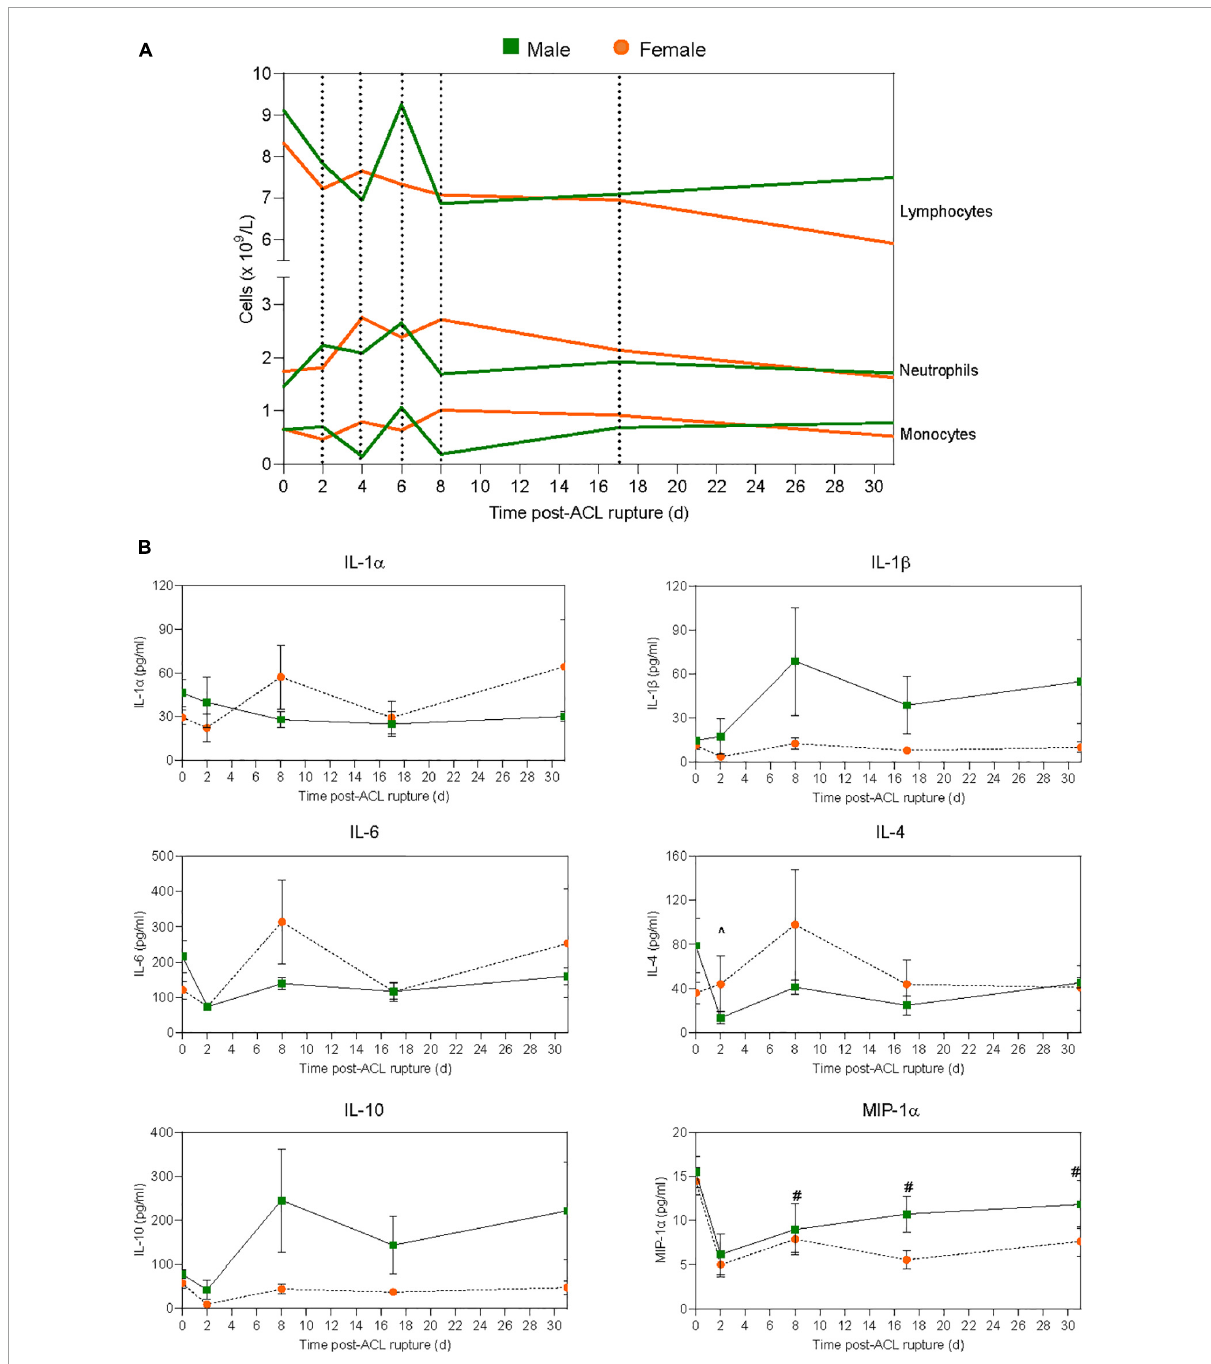
FIGURE2 Systemic inflammatory responses to ACL rupture. Changes in (A) circulating lymphocyte, neutrophil, and monocyte numbers, and (B) plasma cytokine levels for male (green) and female (orange) animals to day 31 following ACL rupture. IL, interleukin; MIP, macrophage inflammatory protein. Data show mean (hematology) and mean ± SEM (cytokines). Two-way ANOVA, Sidak’s multiple comparisons test, ∧ p < 0.05 male, compared to baseline. # p < 0.05 female, compared to baseline.